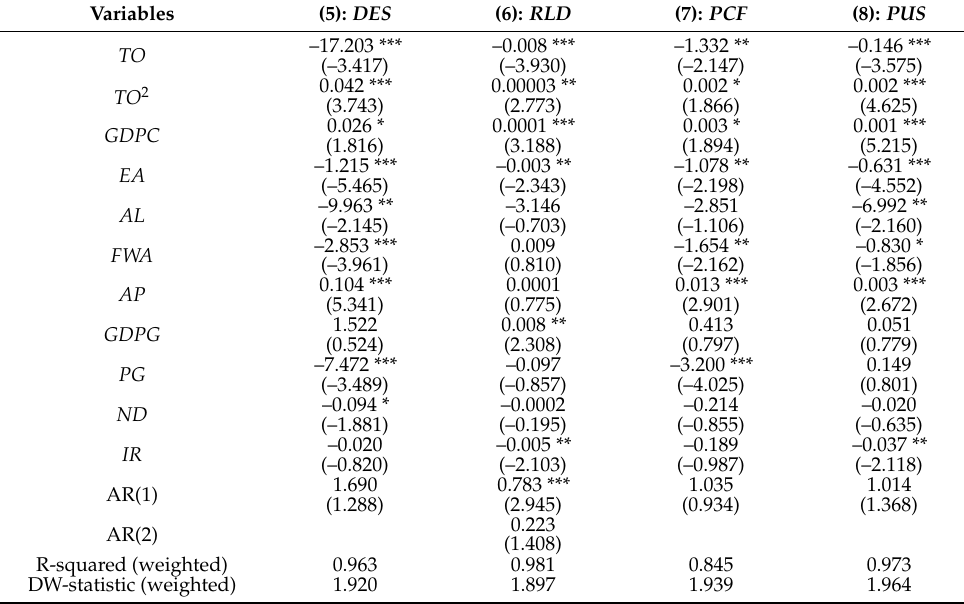
Table 6. Estimation results of LS procedure for pooled